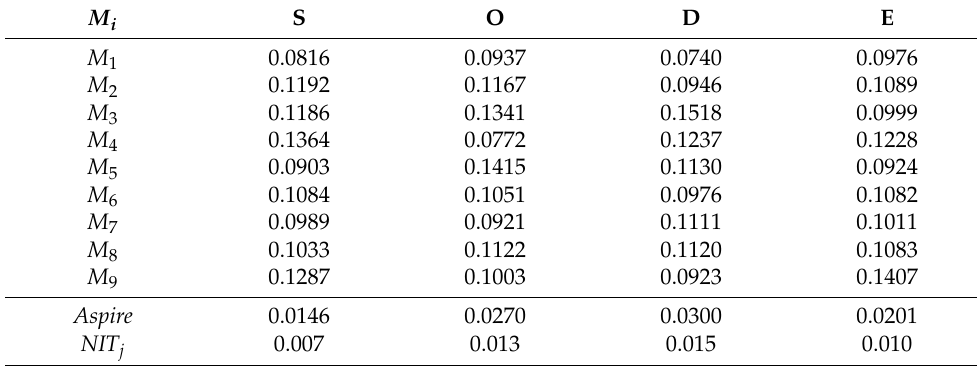
Table 3. The normalized matrix A and the normalized threshold NIT j .